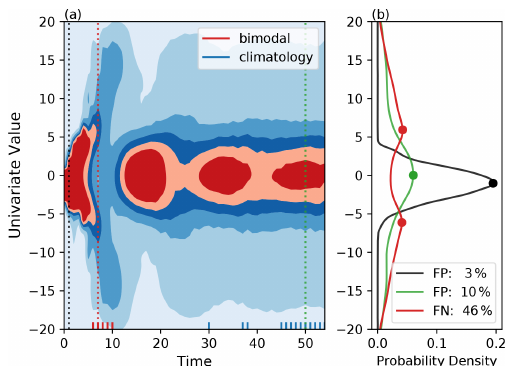
Figure 4. (a) The time evolution of a 10000-member ensemble in a Lorenz 1963 system. x o = ( − 4 . 11 , − 1 . 29 , 26 . 37 ) , r = 28, p = 10, and b = 8 / 3. Shading indicates the kernel density estimate (KDE) of the univariate ensemble distribution. Darker shades of red indi- cate a high number of ensemble members near that value. Red tick marks on the x axis indicate time steps when the ensemble has two modes. Blue tick marks indicate those distributions who are signifi- cantly similar to the climatological distribution according to a two- sided Kolmogorov–Smirnov test ( α = 0 . 025). Climatology was de- termined by integrating the model until t = 200. (b) Discrete distri- butions drawn from the time series in panel (a) . Dots indicate where the maxima occur. The legend indicates the false-positive (negative) detection rate of unimodal (bimodal) distributions according to re- peatedly drawn 50-member ensembles with the bimodal criteria de- rived from Fig. 3